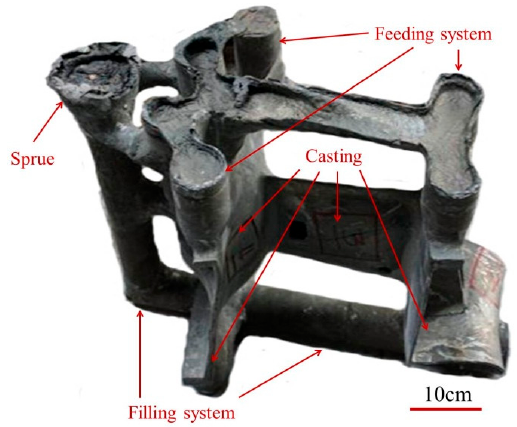
Figure 1. Photo of the superalloy casting.